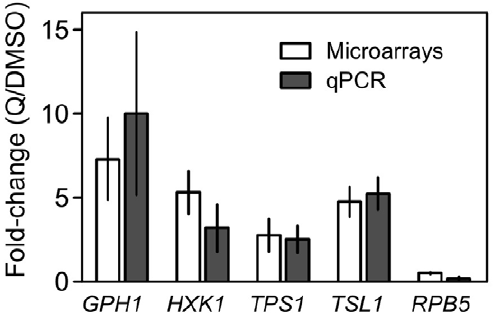
Figure 3. Effect of quercetin (Q) on GPH1,HXK1,RPB5,TPS1and TSL1 mRNA levels. Transcription profile of GPH1 (glycogen phos- phorylase), HXK1 ( hexokinase isoenzyme 1), RPB5 (RNA polymerase subunit), TPS1 (synthase subunit of trehalose-6-phosphate synthase/ phosphatase complex) and TSL1 (subunit of trehalose 6-phosphate synthase/phosphatase complex) were evaluated by microarrays analysis (white bars; mean 6 SD of six arrays) and by qPCR (grey bars). The mean normalized fold expression by qPCR was calculated relative to the transcription of the reference genes RPS6A (component of the small (40S) ribosomal subunit) and ACT1 (actin). The results (mean and SD of triplicates) of a representative experiment (out of three independent experiments) are